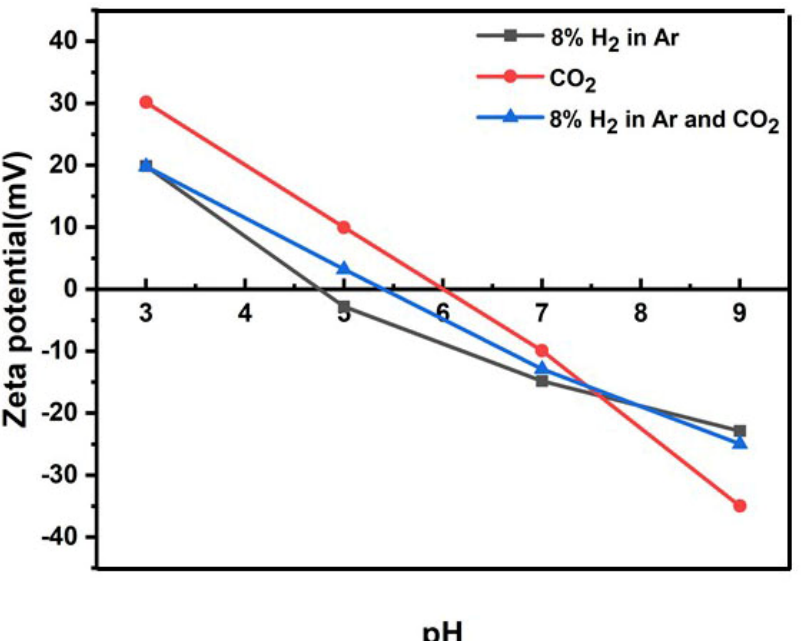
Figure 2. Zeta potential as a function of pH for 8% H 2 in Ar, CO 2 , and a mixture of 8% H 2 in Ar and CO 2 gas nanobubble in water [35].